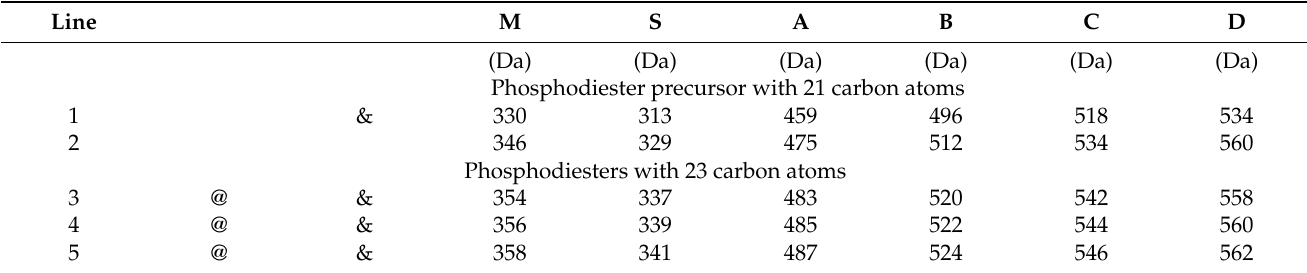
Table 1. Mass spectrometry of phosphocholine